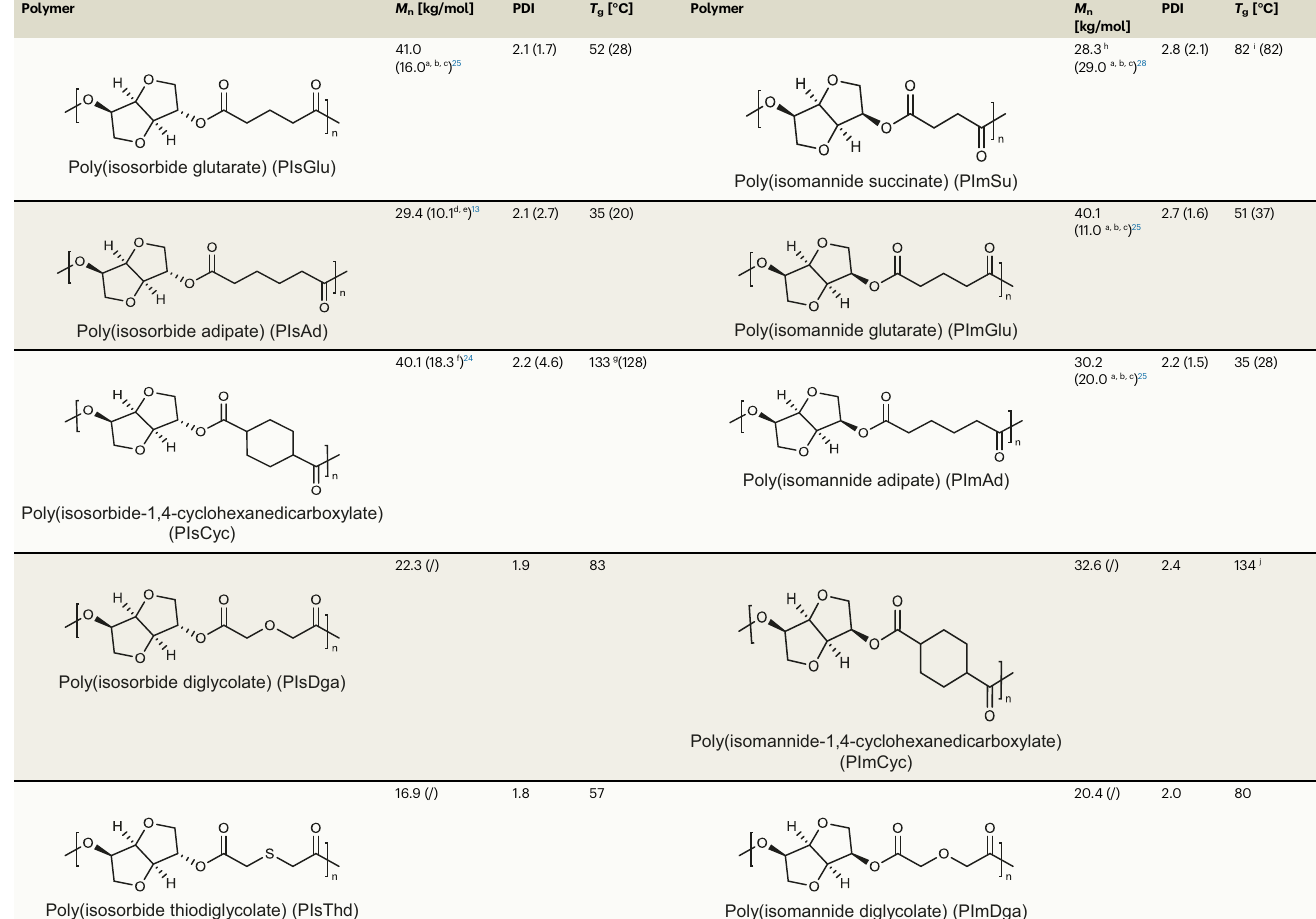
Table 5 | Polyesters synthesized with isosorbide, isomannide and aliphatic diacids by p -cresol assisted polyesteri fi cation Polymer M n [kg/mol] PDI T g [°C] Polymer